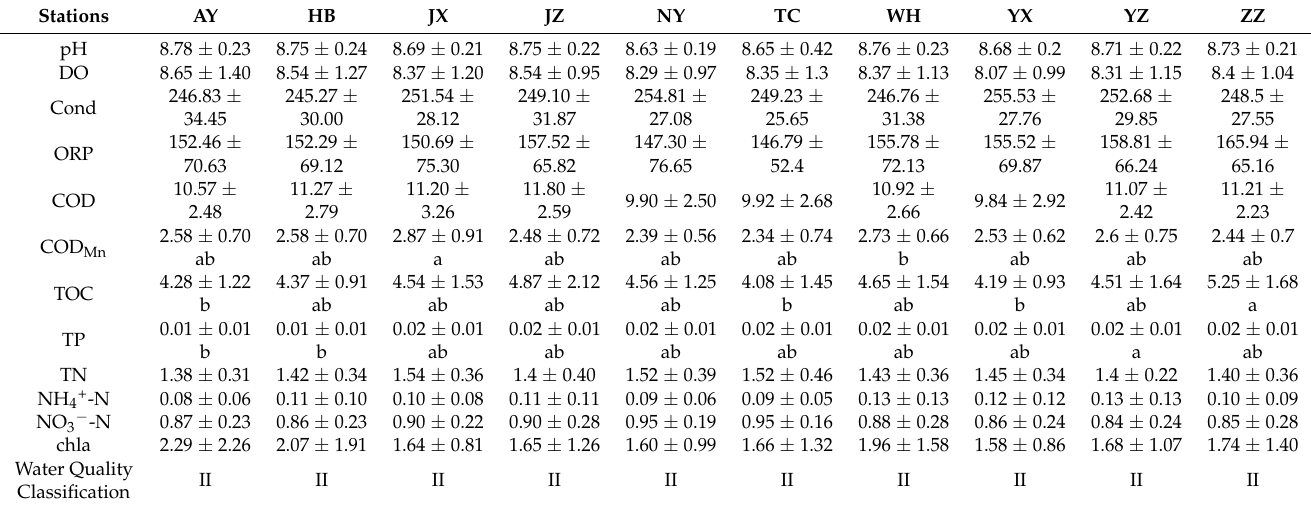
Table 2. Physical and chemical characteristics of water quality in different locations of the MRP in Henan Province.